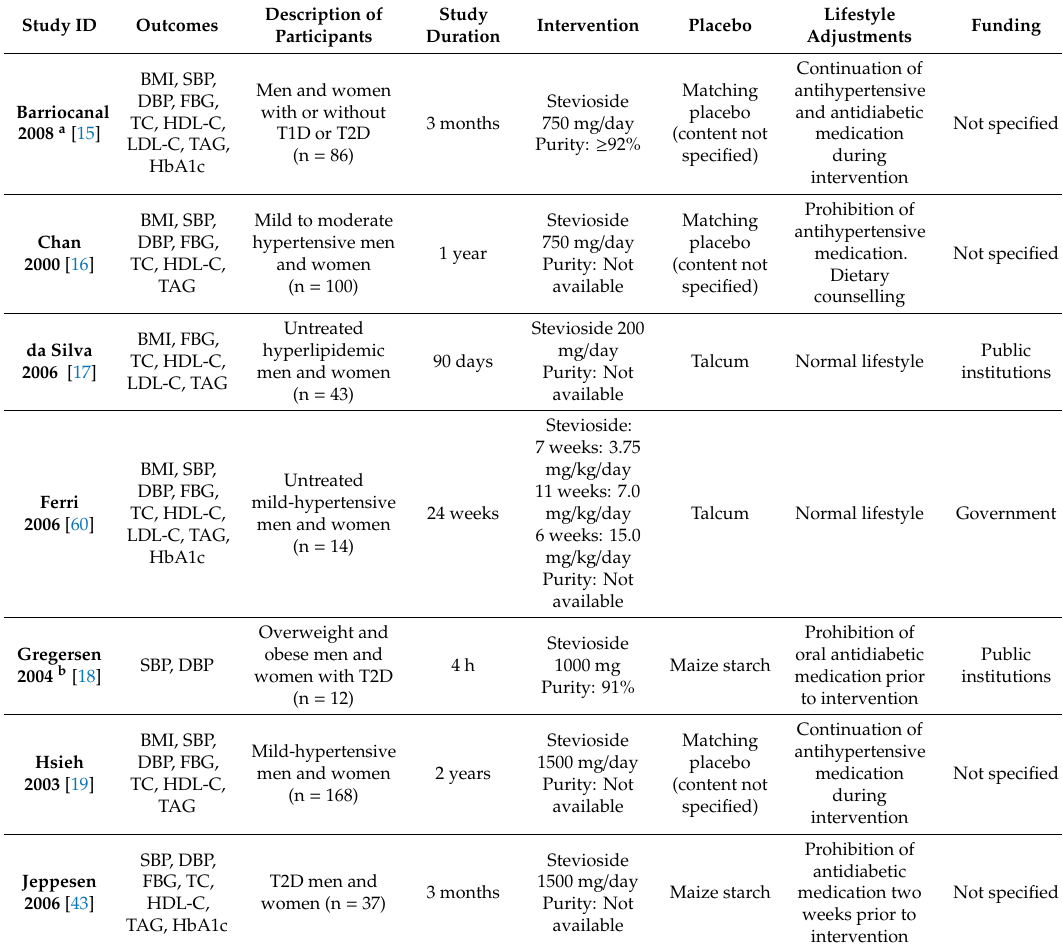
Table 1. Characteristics of included randomized controlled trials